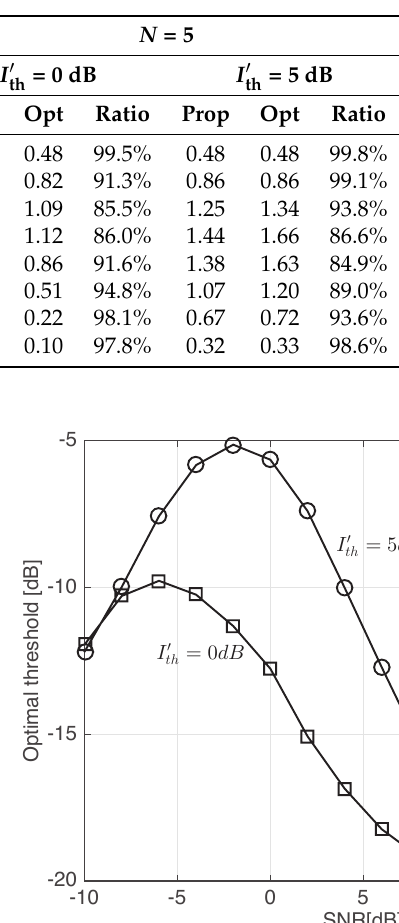
Figure 6. Optimal threshold in the proposed scheme when all channels are i.i.d. , N = 10, and I (cid:48) or 5